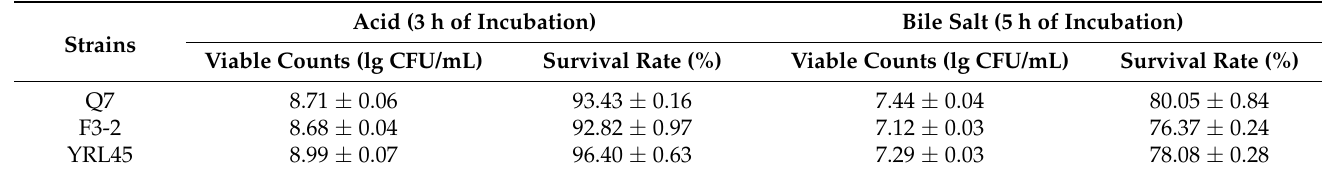
Table 4. Acid and bile salt tolerance of L. plantarum Q7, L. plantarum F3-2 and L. plantarum YRL45.